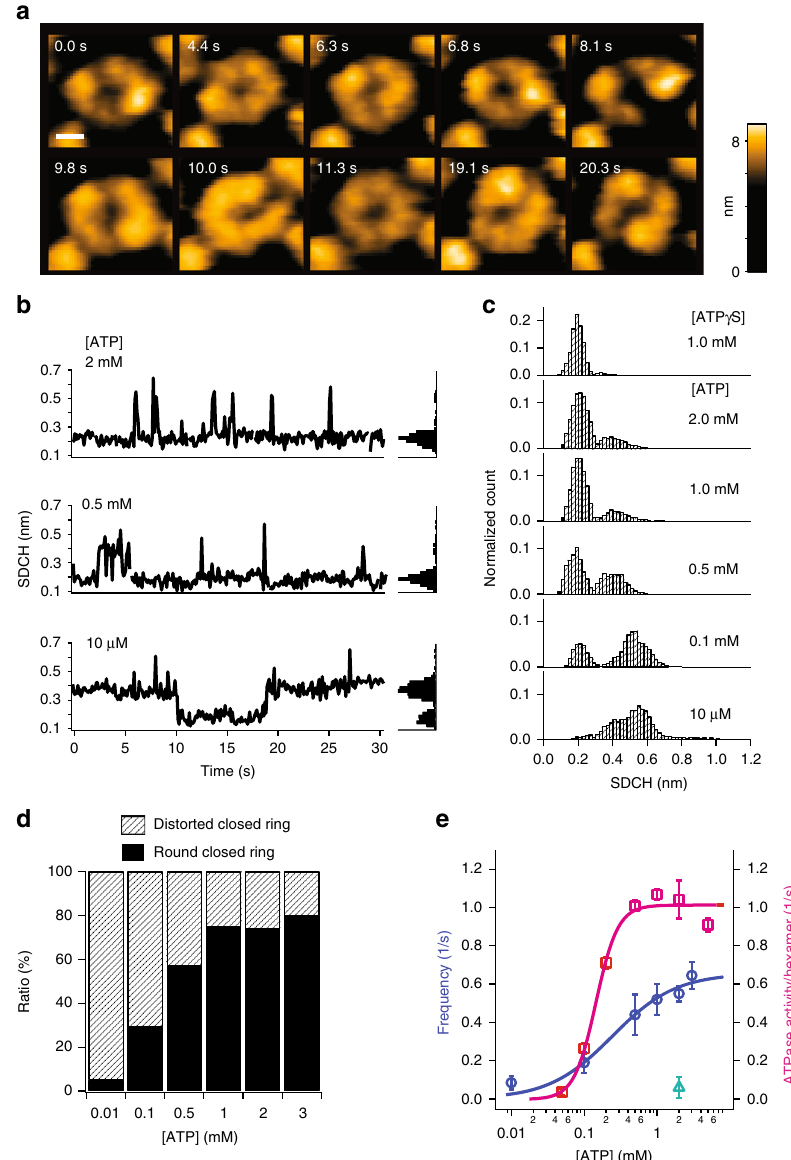
Fig. 2 Conformational dynamics of Δ N- T ClpB. a Clipped HS-AFM images from those successively captured at 10 fps in the presence of 10 μ M ATP. Scale bar, 5 nm. Z color bar, 0 to 9.1 nm. b Typical time courses of SDCH measured along the hexamers in the presence of different [ATP] (left) and corresponding histograms of SDCH (right). c Histograms of SDCH measured at various [ATP] and 1 mM ATP γ S. d Percentages of round (black area) and distorted (hatched area) closed forms at various [ATP]. e ATPase activity (magenta open squares) and frequency of structural transition cycles between the round and distorted closed forms (blue open circles) as a function of [ATP]. The ATPase activity was fi tted by Hill ’ s equation with the Hill coef fi cient of 2.6 ± 0.6 and the K m of 0.16 ± 0.02 mM (means ± s.d., magenta line). The transition frequency was well fi tted by the Michaelis – Menten equation with K m = 0.35 ± 0.13 mM (mean ± s.d., blue line). A green open triangle indicates the frequency observed at 2 mM ATP γ